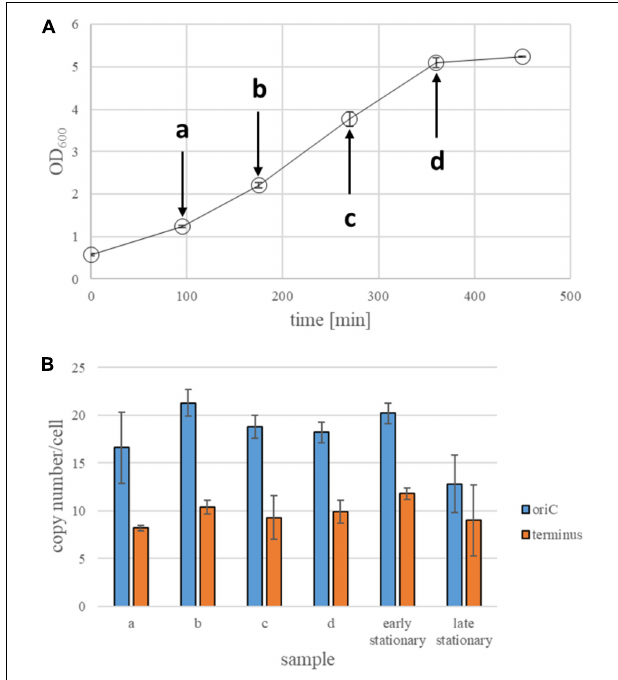
FIGURE 2 | Quantification of origin and terminus copy numbers in strain Zm6N under anaerobic conditions. (A) Growth curves of Zm6N strain under anaerobic conditions. Average OD 600 values of three biological replicates and their standard deviations are shown. Arrows indicate time points of